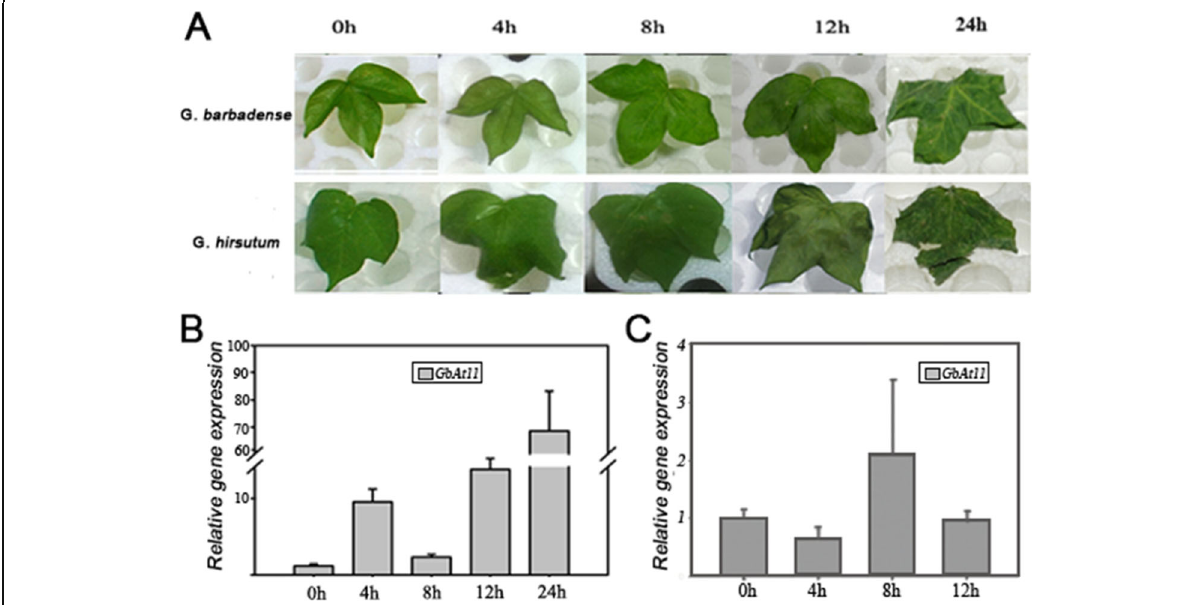
Fig. 1 GbAt11 expression is specifically induced by Verticillium dahliae toxin in Gossypium barbadense. a The representative G. barbadense and G. hirsutum leaves after treated with V. dahliae spore suspension (1 × 10 6 per mL) for indicated times. b-c Transcription changes of GbAt11 gene in G. barbadense ( b ) and G. hirsutum ( c ) after treated with V. dahliae spores (1 × 10 6 /mL) for indicated